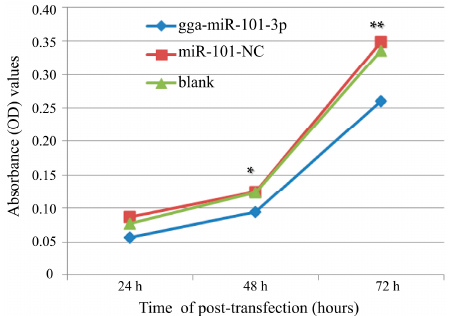
Figure 5. Over-expression of gga-miR-101-3p inhibited DF-1 cell proliferation. DF-1 cells were transfected with gga-miR-101-3p or the negative control. A mock transfection was set as a blank. At 24 h, 48 h, 72 h of post-transfection, the cell proliferation was measured using an MTT-Cell Proliferation and Cytotoxicity Assay Kit (Beyotime, Beijing, China). Plotted means and standard deviation were computed from data of three independent experiments, and the relative cell growth is shown. The asterisks represented statistically significant differences (* p <0.05, ** p < 0.01). Next, we assessed the effects of gga-miR-101-3p on cell cycle distribution by flow cytometry. In DF-1 cells, gga-miR-101-3p significantly reduced the percentage of S-phase cells, but increased the percentage of G1-phase cells (Figure 6). Taken together, these results indicate that over-expression of